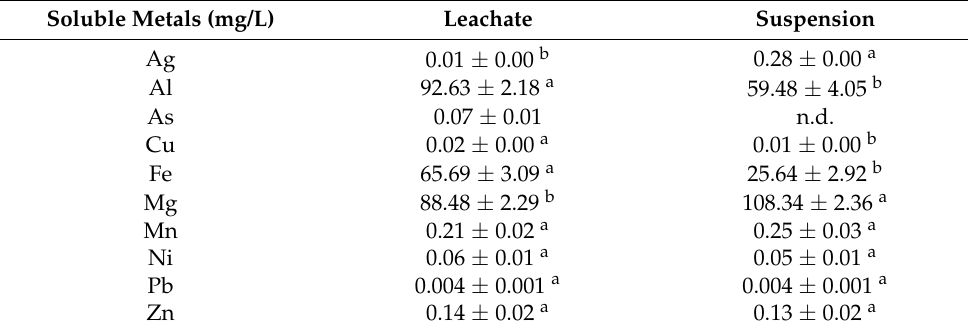
Table 8. Soluble metal content in treated Carey samples (leachate and